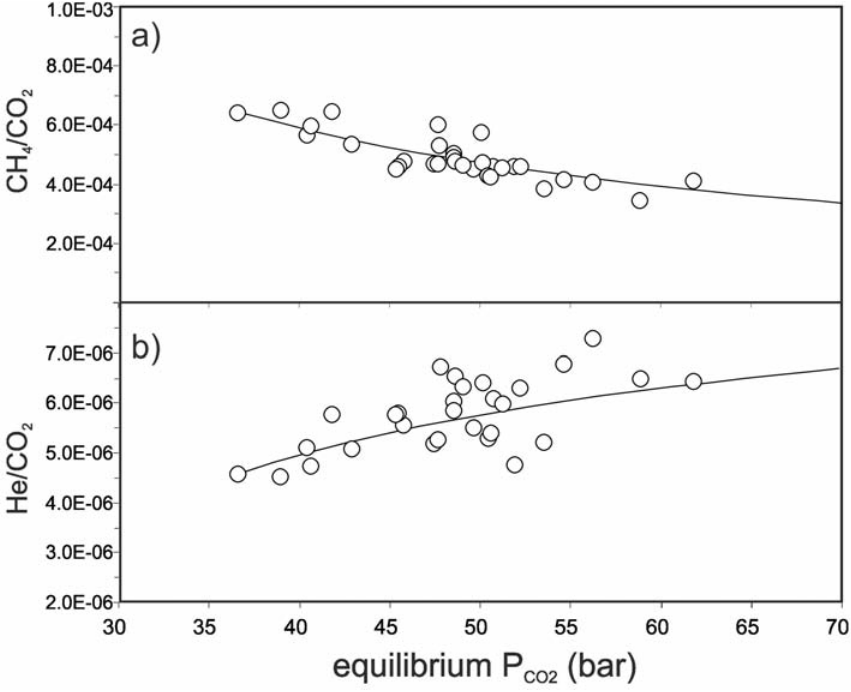
Figure 9. CH /CO (a) and He/CO (b) ratios of fumarolic fluids versus equilibrium P 4 2 2 hypothetical magmatic gas characterized by the absence of CH deep, possibly magmatic, fluids caused the 2002